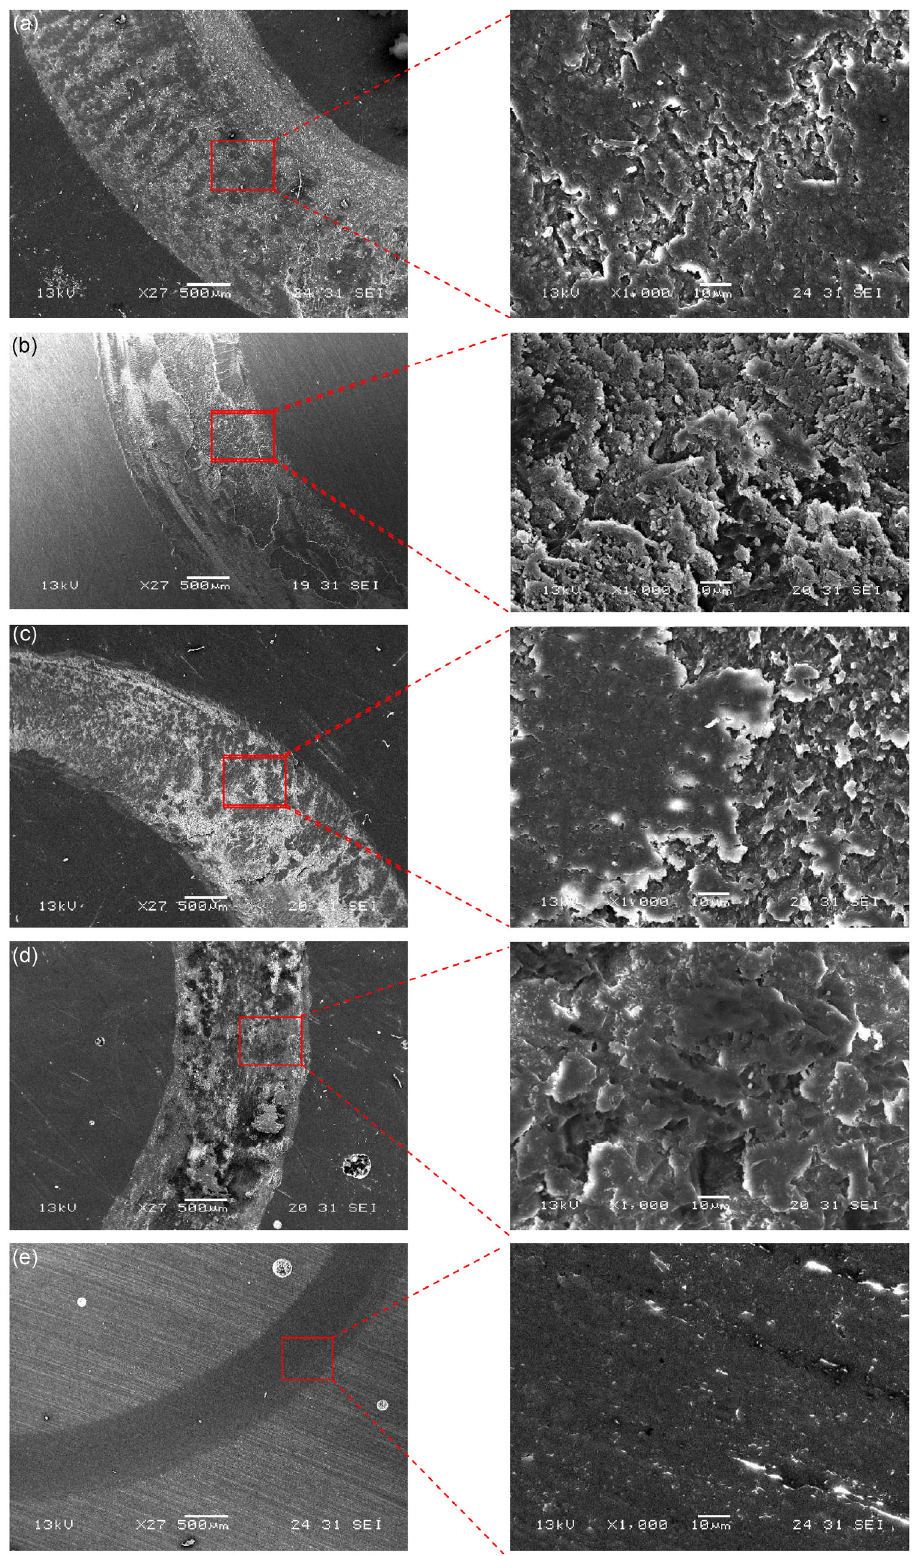
Fig. 7 SEM observation of worn surfaces for the different types of samples: (a) Ep, (b) Ep-Gr, (c) Ep-CNT, (d) Ep-HYB, and (e)